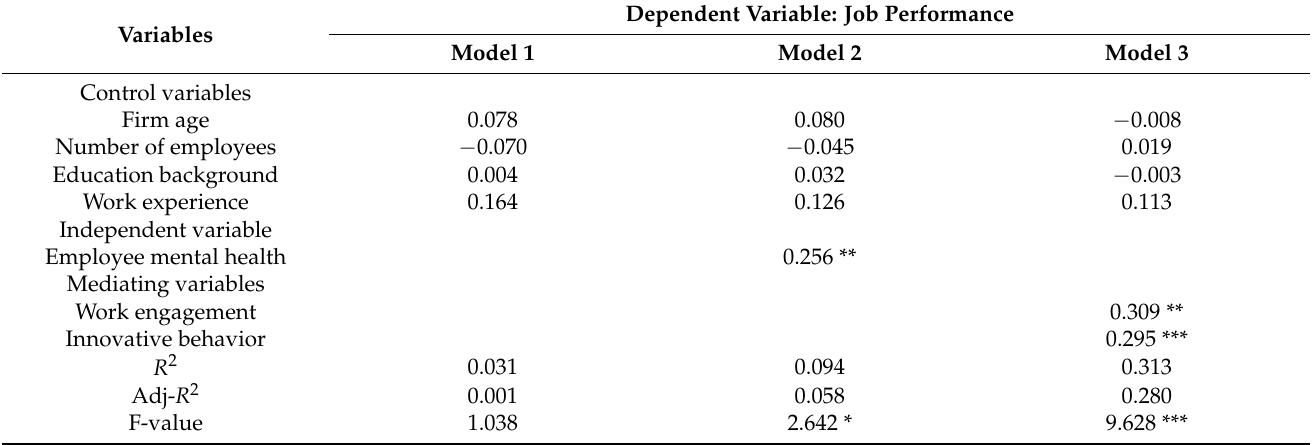
Table 2. The results of regression analysis (models